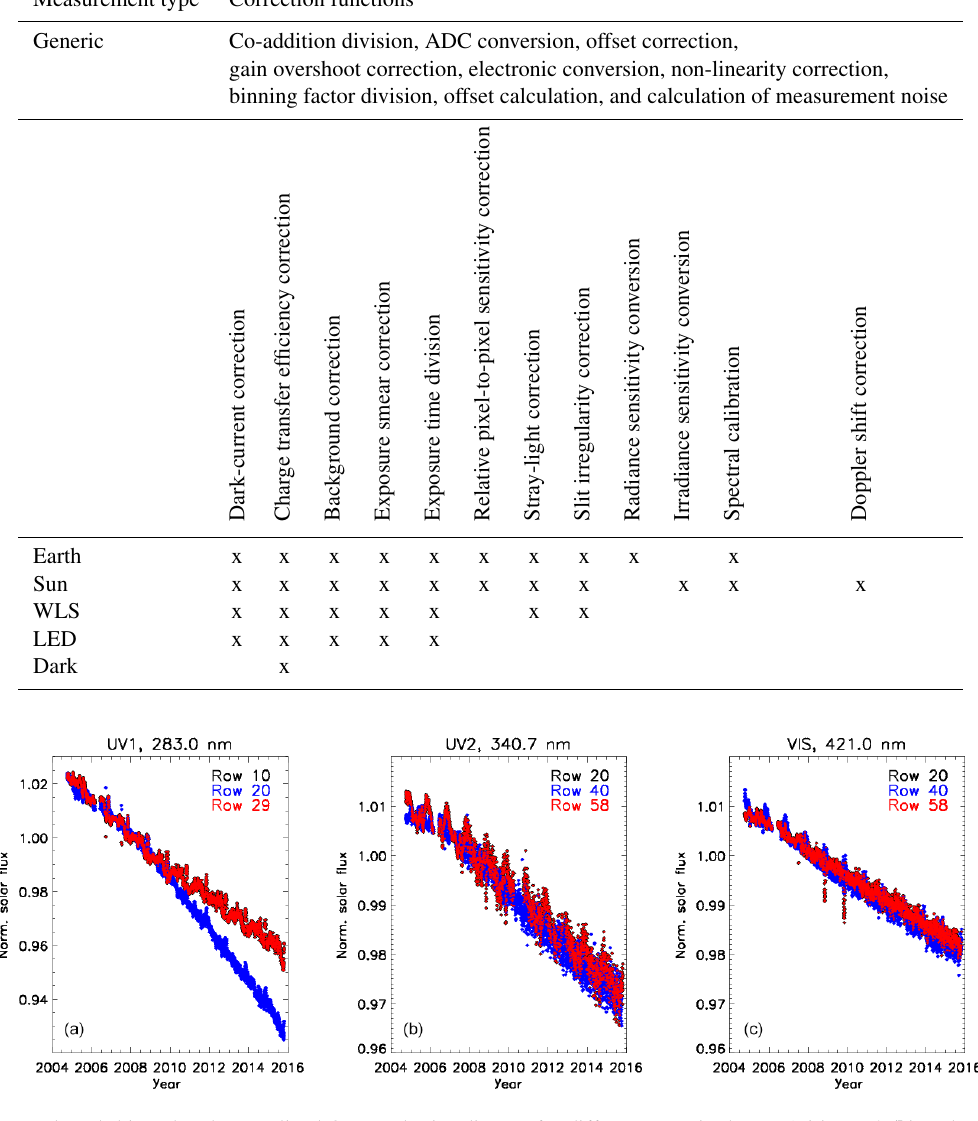
Figure 27. The wavelength-binned and normalized QVD solar irradiances for different rows in the UV1 (a) , UV2 (b) and VIS (c) channels. The increase in change with decreasing wavelength is typical of optical degradation related to solar exposure. The anomalous change in the UV1 row 20 beginning in 2009 may be caused by additional solar exposure resulting from the row-anomaly